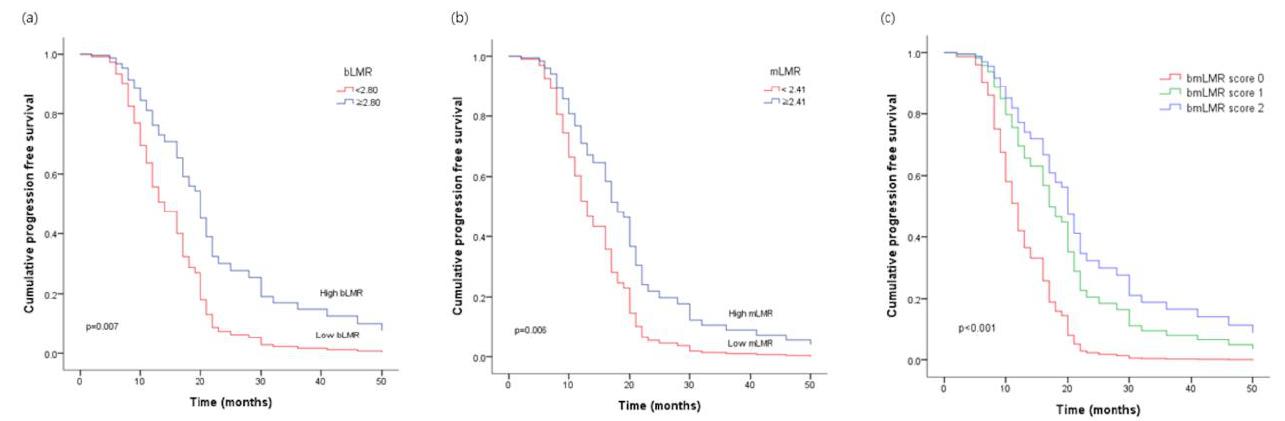
Figure 1. Progression-free survival of ovarian cancer patients according to ( a ) the lymphocyte-to- monocyte ratio in peripheral blood (bLMR), ( b ) the lymphocyte-to-monocyte ratio in malignant fluid (mLMR), ( c ) the new score: bmLMR score.